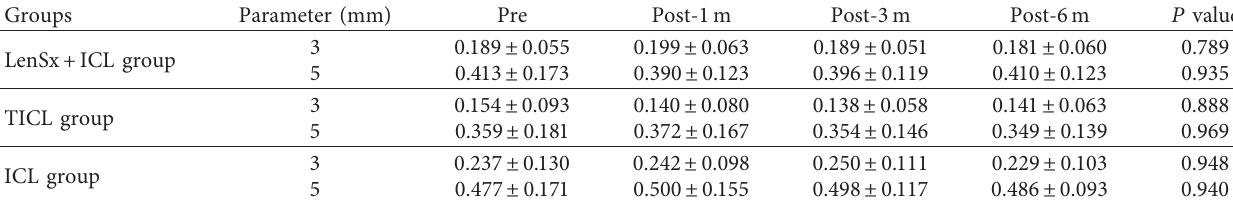
Table 4: The total HOAs in three groups before and after